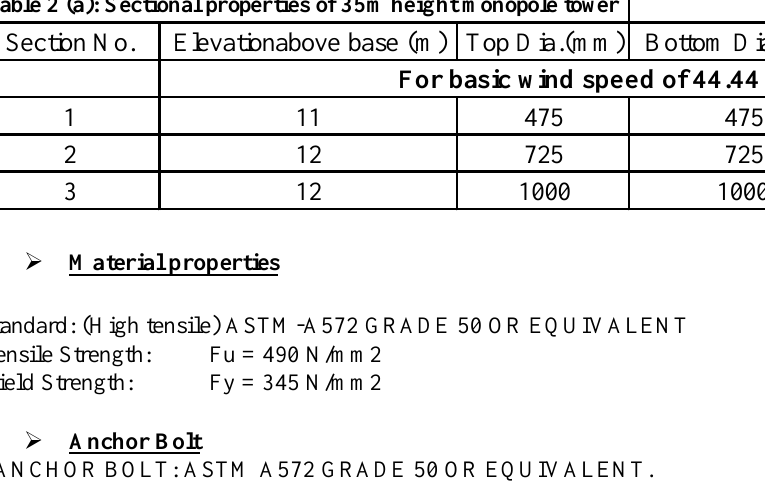
Table 2 (a): Sectional properties of 35m height monopole tower Section